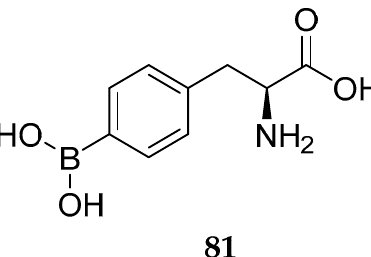
Figure 8. BPBA compound ( 81 ), disruptor of Rev ‐ RRE interaction and inhibitor of HIV ‐ 1